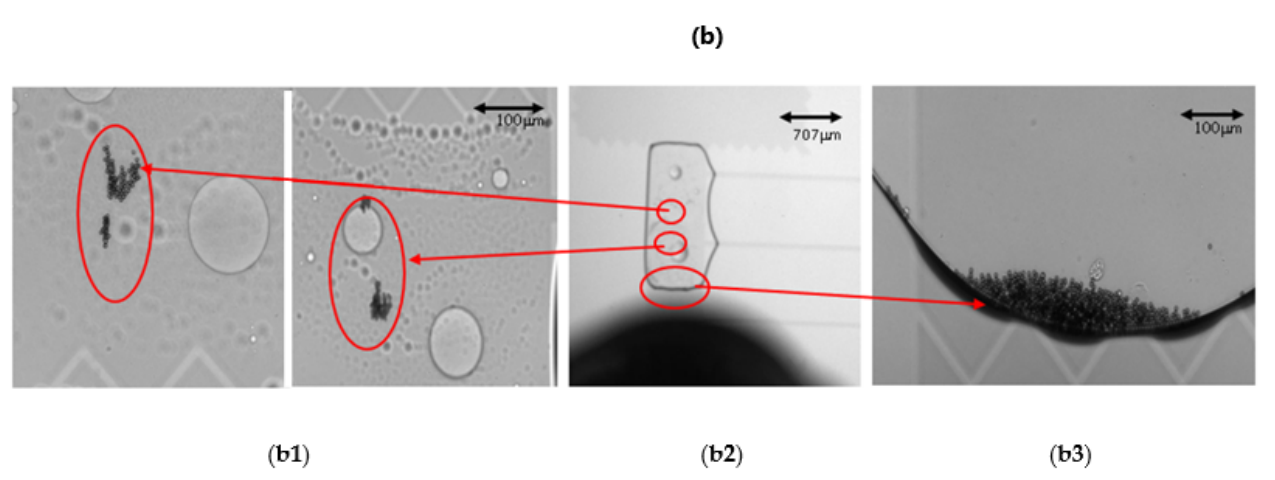
Figure 8. Beads aggregation issue with too few or too many beads. ( a ) 25 magnetic beads: ( a1 ) Some magnetic beads cannot be aggregated; ( a2 ) The droplet with 25 magnetic beads, black shadow was the magnet; ( a3 ) Some magnetic beads could not be aggregated. ( b ) More than 500 magnetic beads: ( b1 ) Some magnetic beads were stuck and could not be moved; ( b2 ) The droplet with more than 500 beads; ( b3 ) Some successfully aggregated beads.